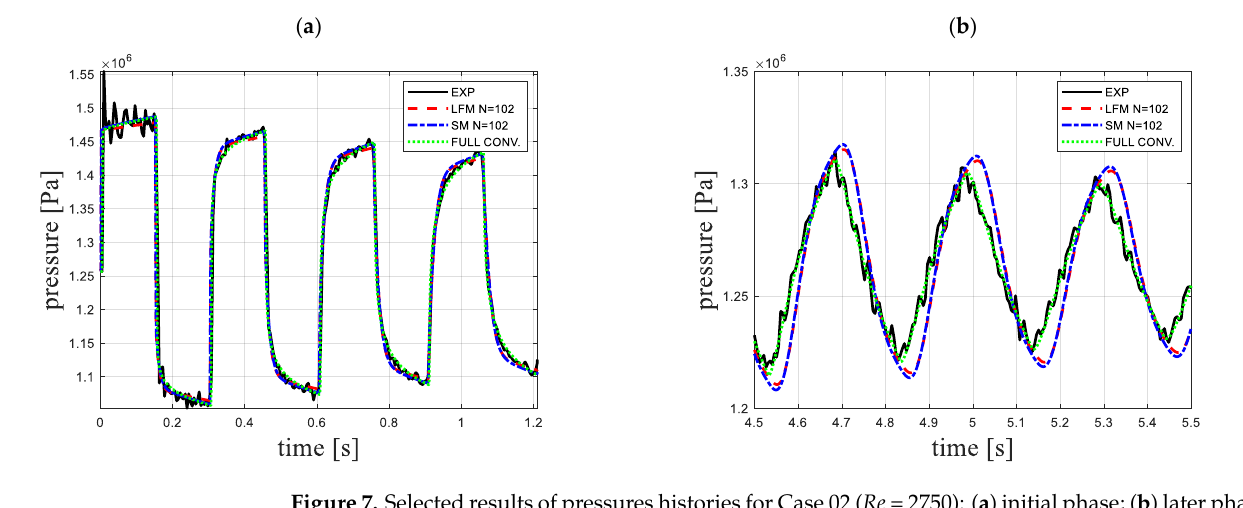
Figure 8. Enlargement of pressure histories of the first three amplitudes for Case 02 ( Re = 2750): ( a ) crest, ( b ) valley.